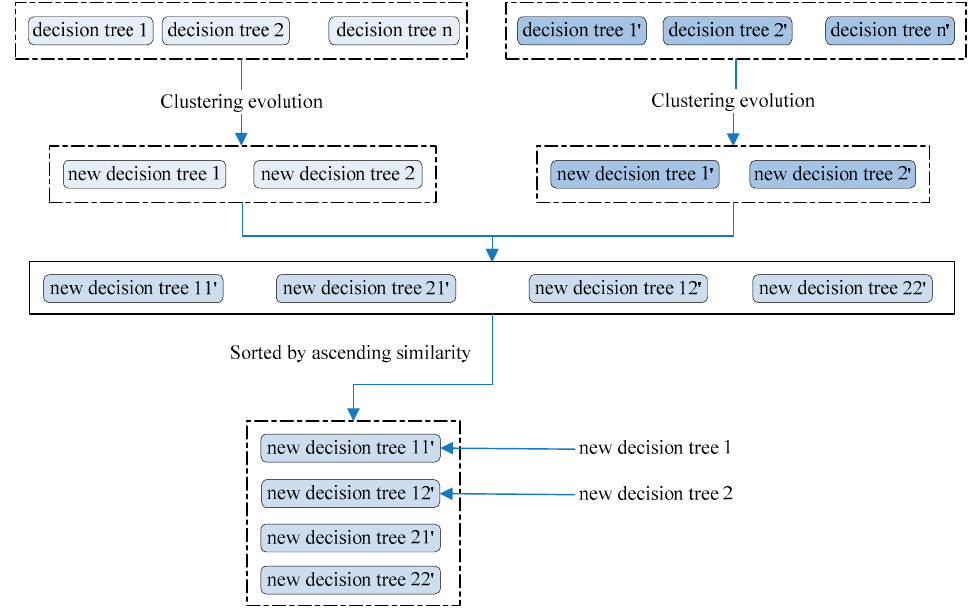
Figure 4. The schematic diagram of genetic evolution. The clustering evolutionary was used to select the parent. the